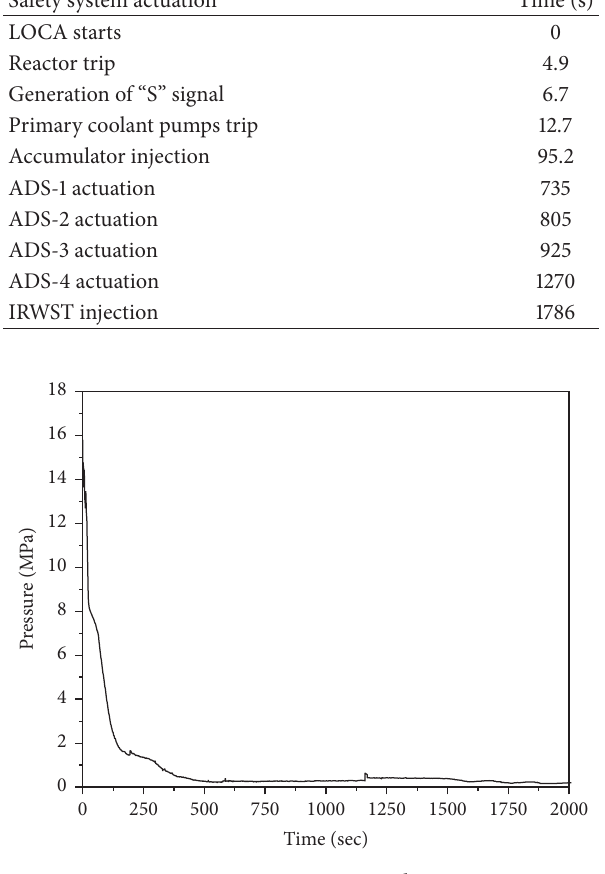
Figure 3: Primary system pressure during LOCA.